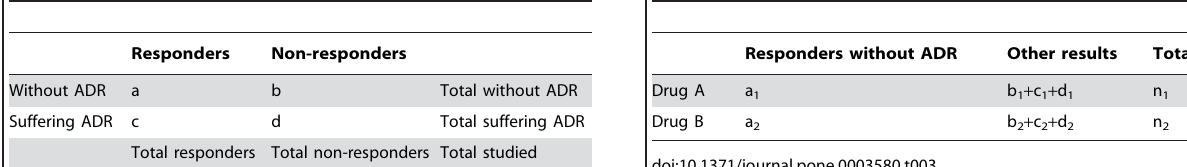
Table 1. 2 6 2 table combining efficacy and safety results of a theoretical CRT.